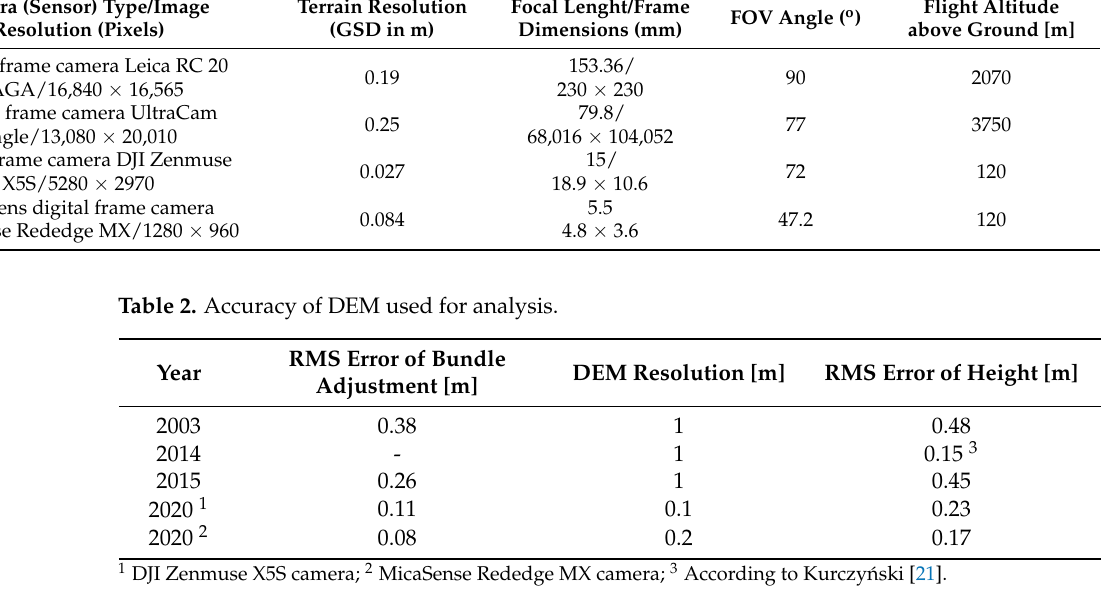
Table 1. The cameras used and actual ground resolution of the obtained photogrammetric images. Camera (Sensor) Type/Image Resolution (Pixels)